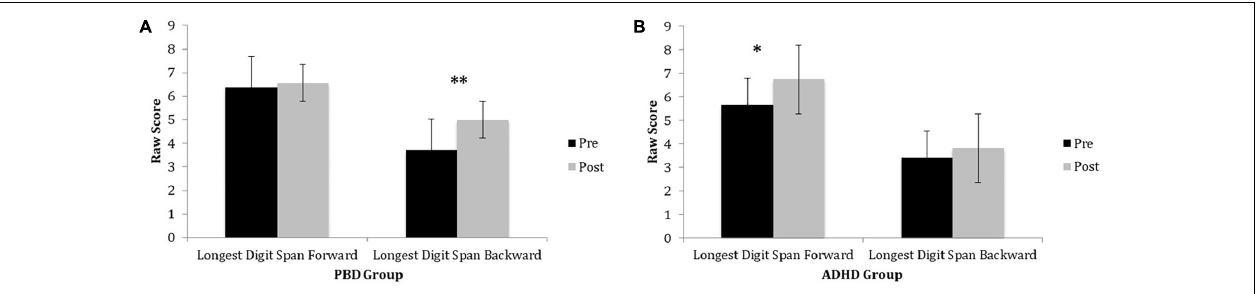
FIGURE 1 | Digits Span Task performance in PBD and ADHD before and after Cogmed training. (A) Bar graph representing raw scores for the PBD group. (B) Bar graph representing raw scores for the ADHD group. PBD, pediatric bipolar disorder; ADHD, attention deficit-hyperactivity disorder; Pre, pre-training scores; Post, post-training scores. ∗ p < 0.05; ∗∗ p <